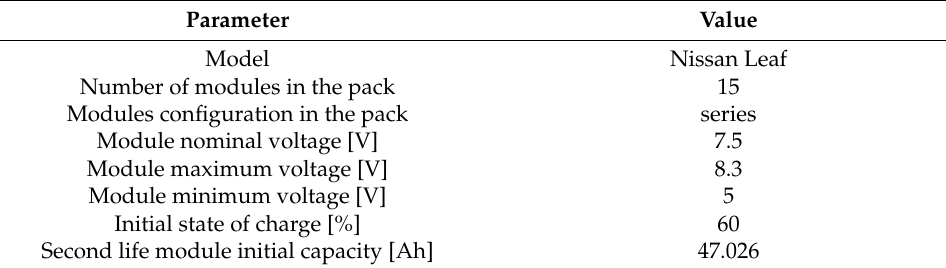
Table 2. Second life battery pack specifications